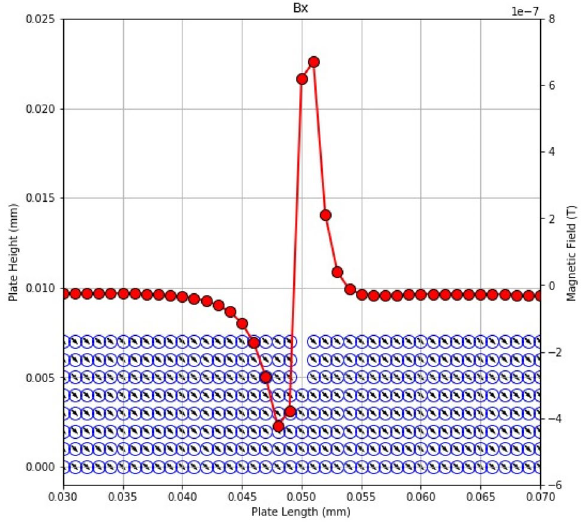
Fig. 8 Magnetic field X of a rectangular defect with ordered mag- netic domains